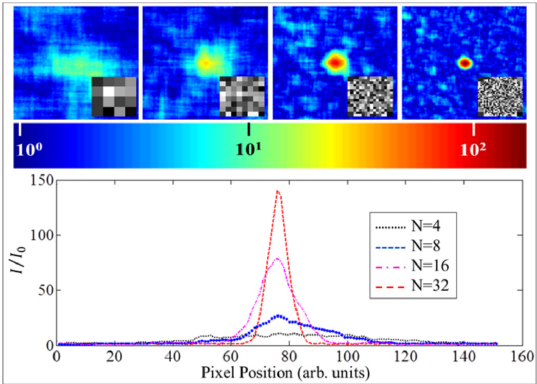
Figure 7. Optimized reflective inverse diffusion spot intensities for the brushed aluminum reflector for N = 4 through 32 (top) and corresponding intensity cross-sections (bottom).